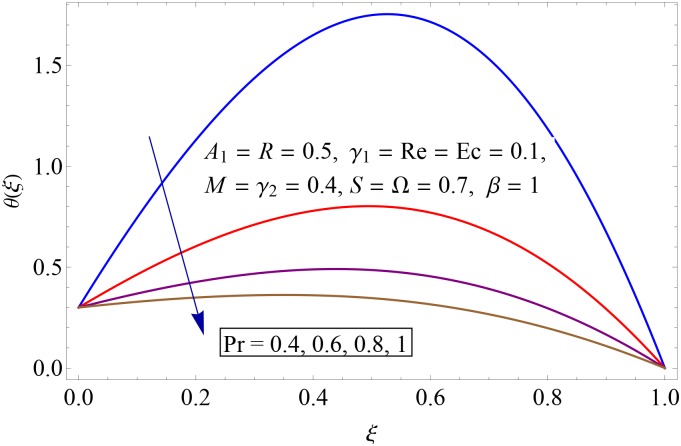
Impact of Pr on θ(ξ).